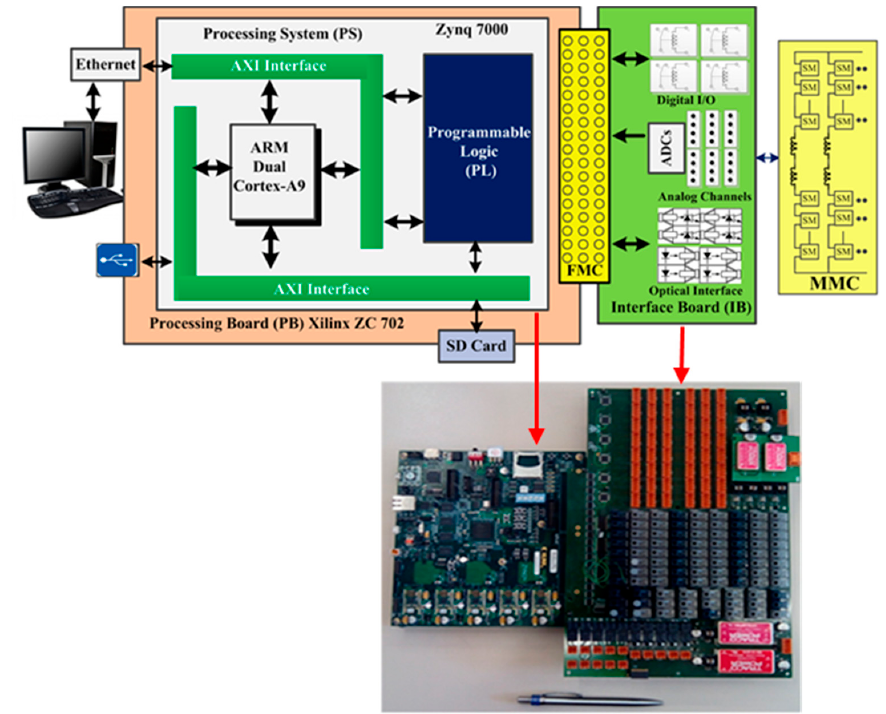
Figure 20. Processing platform: block diagram and picture.